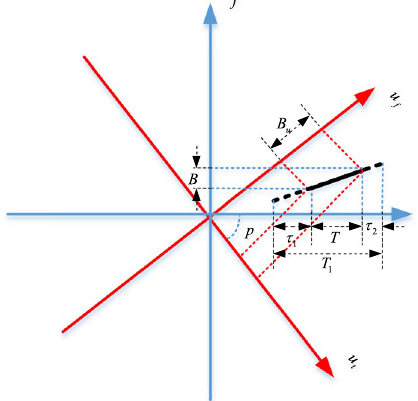
Fig. 3 Corresponding relation between echo signal fractional